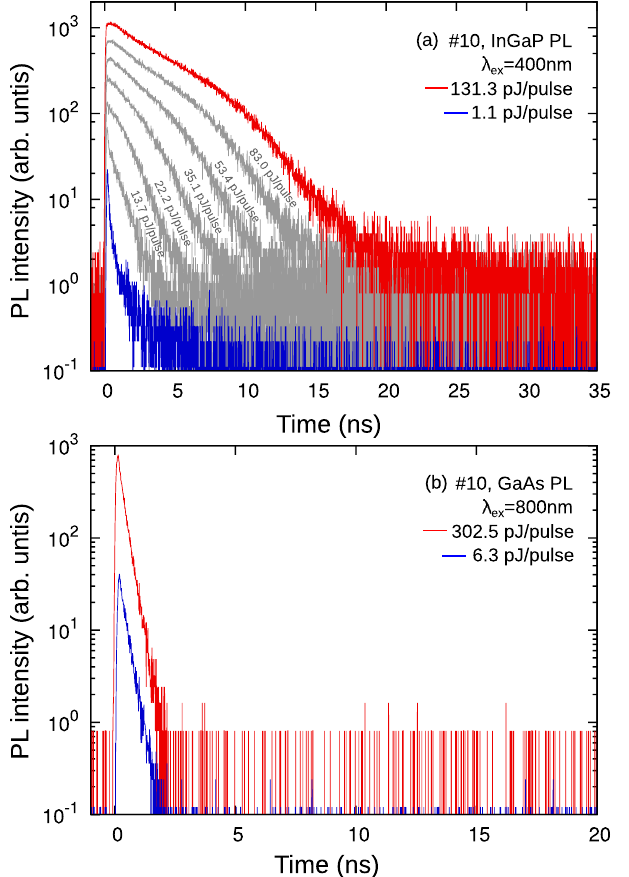
Figure 4. Power dependence of PL decays from ( a ) InGaP and ( b ) GaAs subcell of sample #10, after